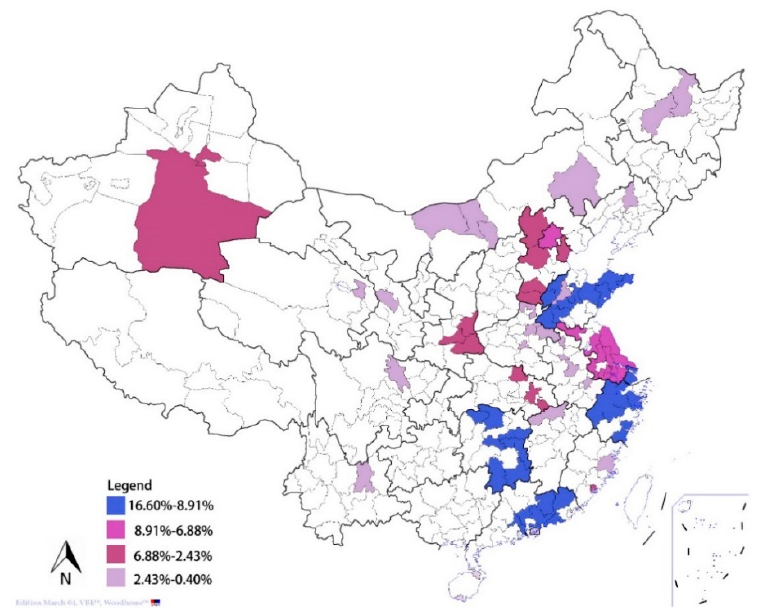
Figure 1. The spatial distribution of photovoltaic applications across China’s urban areas.